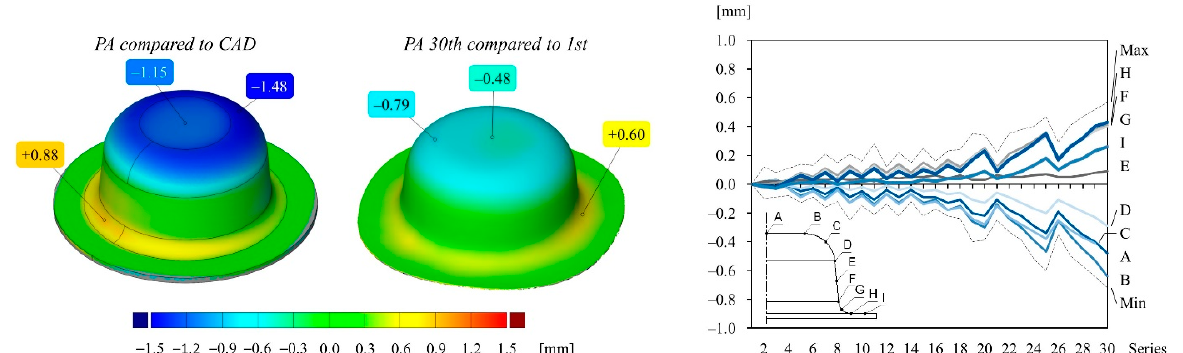
liquid or gaseous mating body.” [40] (p. 108).